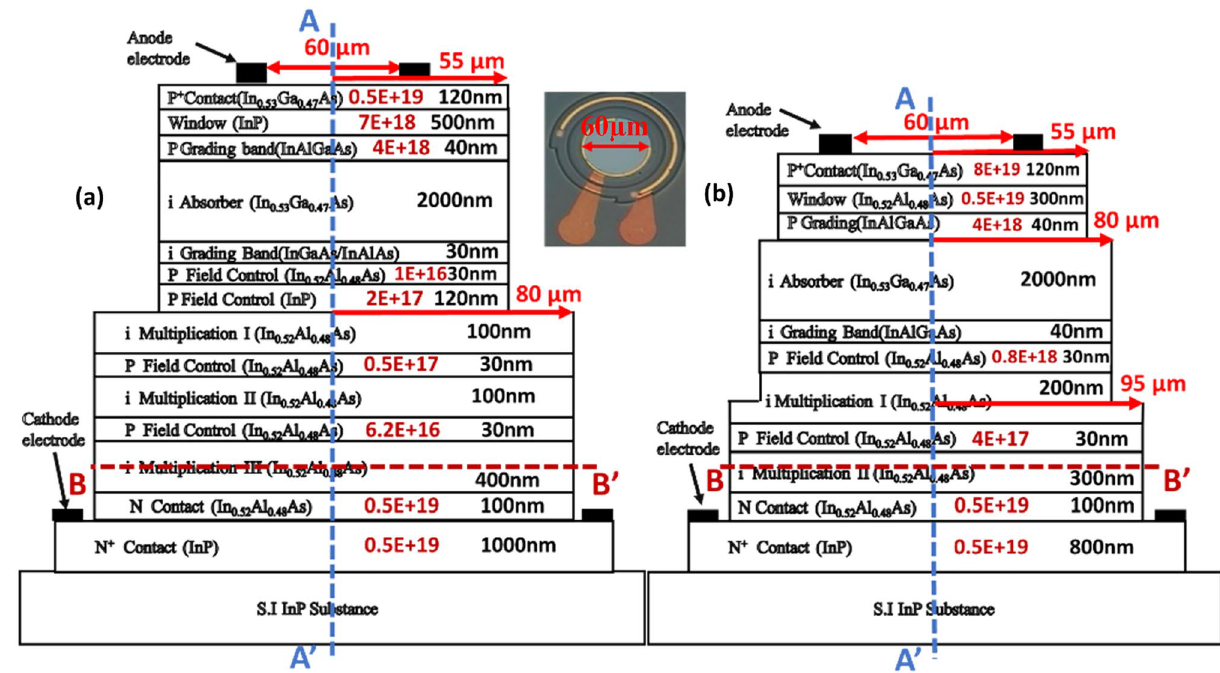
Figure 1. Cross-sectional view of the demonstrated APDs. ( a ) Triple M layer (Device A). ( b ) Dual M layer (Device B). Inset shows the top view with an active window diameter of 60 µm in both cases. The thickness and doping density (cm −3 ) of each layer have been